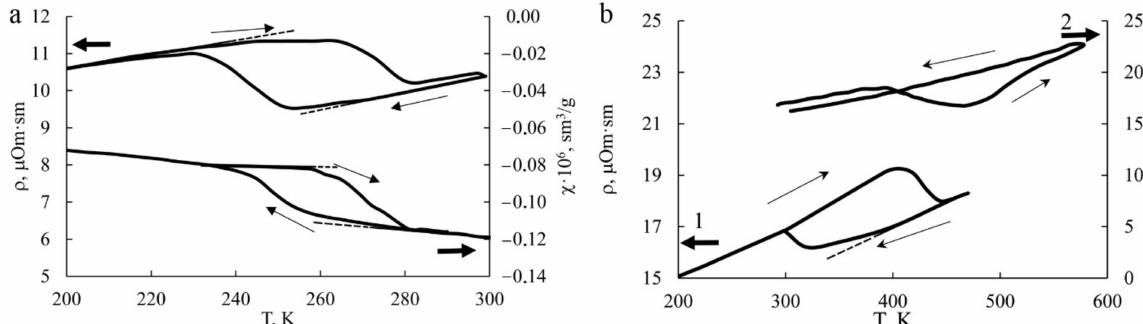
Figure 8. ( a ) The temperature dependences ρ (T) and χ (T) of the Cu-14Al-3Ni alloy after quenching from 1223 K in water in the measurement cycle 300 K → LN → 300 K; and ( b ) temperature dependences of ρ (T) of the Cu-14Al-3Ni alloy after HPT in the measurement cycles 300 K → LN → 470 K → 300 K (curve 1) and 300 K → 573 K → 300 K (curve 2) (LN is an abbr. for liquid nitrogen). The dotted line shows the pre-transition deviations from the linear dependence of ρ (T) and χ (T) interval of 20–25 K; inside hysteresis loops.